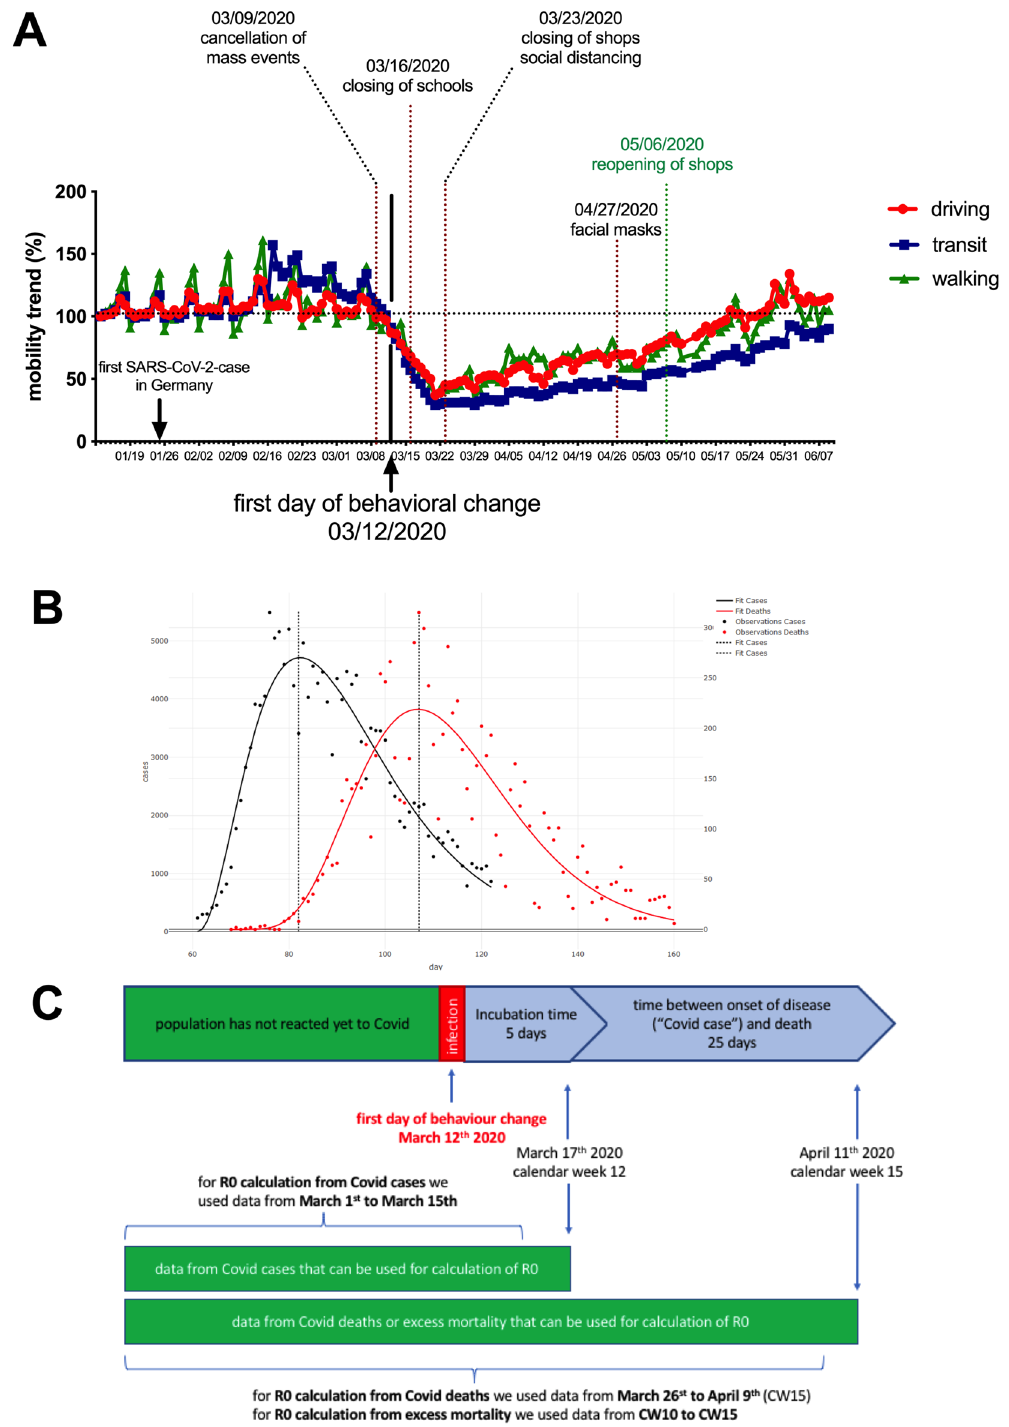
Figure 1. Identifying SARS-CoV-2 datasets unaffected by policies or behavioral changes for estimating R0. ( A ) Mobility data (driving) for Germany, provided by Apple 16 (driving: red; transit: blue; walking: green). The first change in mobility trends is observed for March 13. ( B ) Data provided by RKI for Covid-cases (black) and Covid-19-related deaths (red) were fitted by gamma distribution. The maxima of the two curves are 25 days apart. ( C ) Graphical representation of the date up to which data from Covid-19 disease cases or Covid-19 death cases can be used to determine R0 without affecting the outcome through policy actions or societal